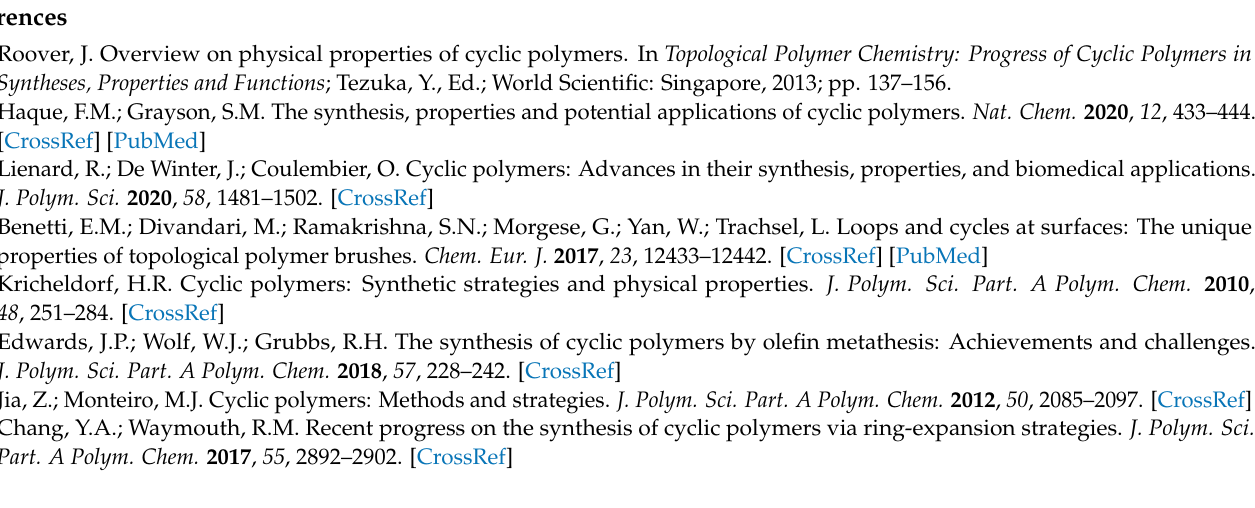
samples, Figure S2: 1 H NMR spectra of Pluronic and PEG samples, Figure S3: 13 C NMR spectra of Pluronic and PEG samples, Figure S4: Temperature-dependent transmittance of l -L64(OH) , Figure S5: Temperature-dependent absorption intensity of DPH in the presence of Pluronic samples, Figure S6: Number and intensity distribution obtained from